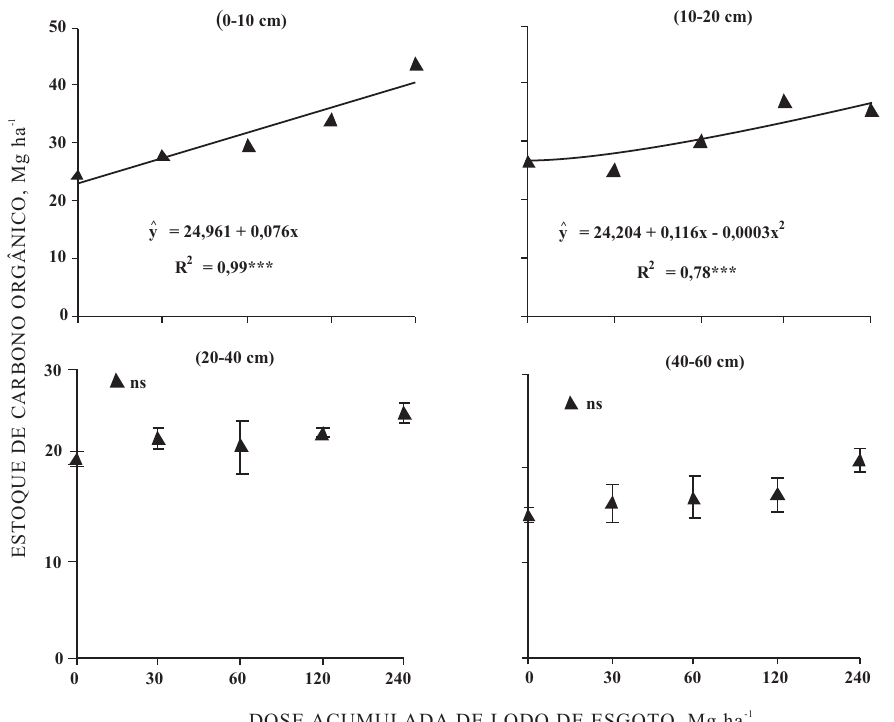
Figura 2. Estoque de carbono orgânico em Latossolo sucessivamente tratado com lodo de esgoto, nas profundidades de 0–10, 10–20, 20–40 e 40–60 cm. (***: Significativo a 0,1 %). As barras verticais referem- se ao desvio-padrão da